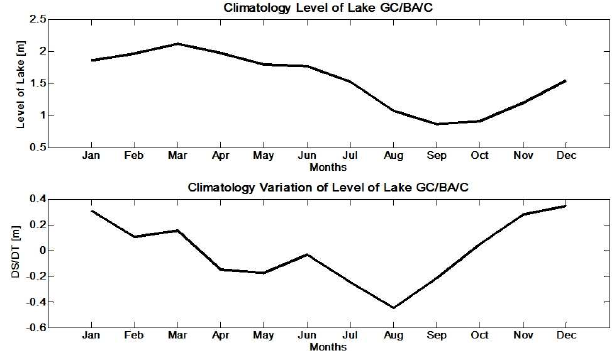
Fig. 3. Monthly mean air temperature for the different in-situ mete- orological stations.